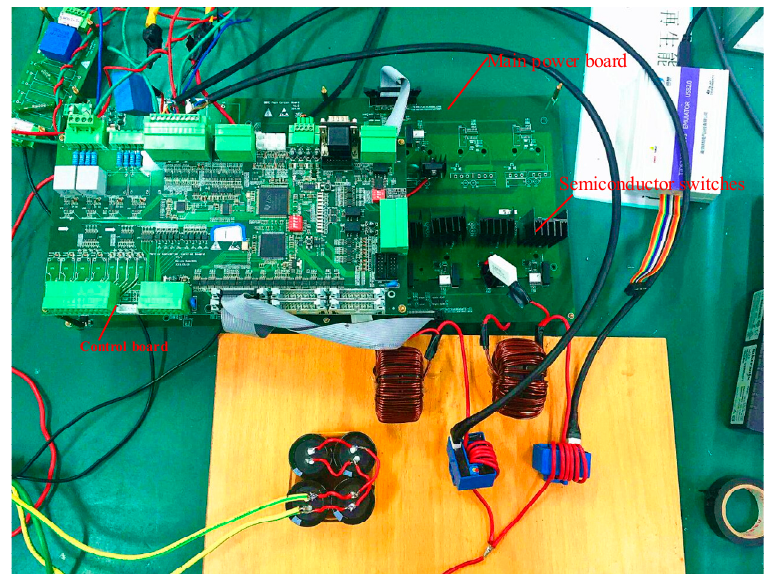
Figure 8. A prototype for the presented converter.